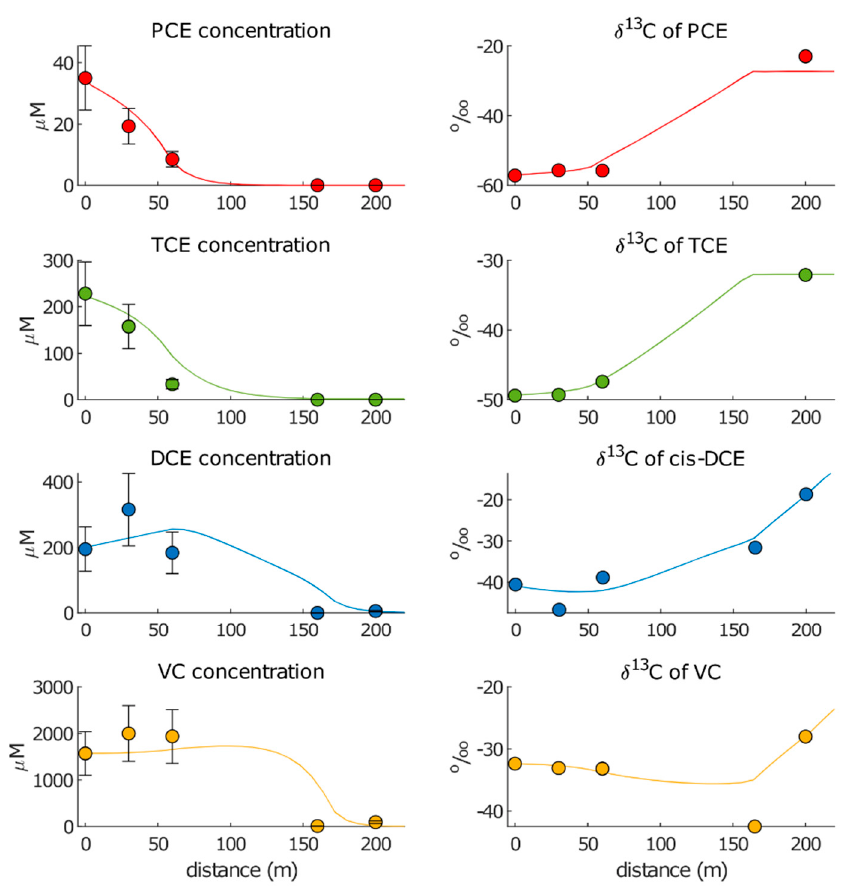
Figure 6. Simulated (lines) and observed (dots) showing the chloroethene concentrations and isotopic compositions in “Approach 2”.